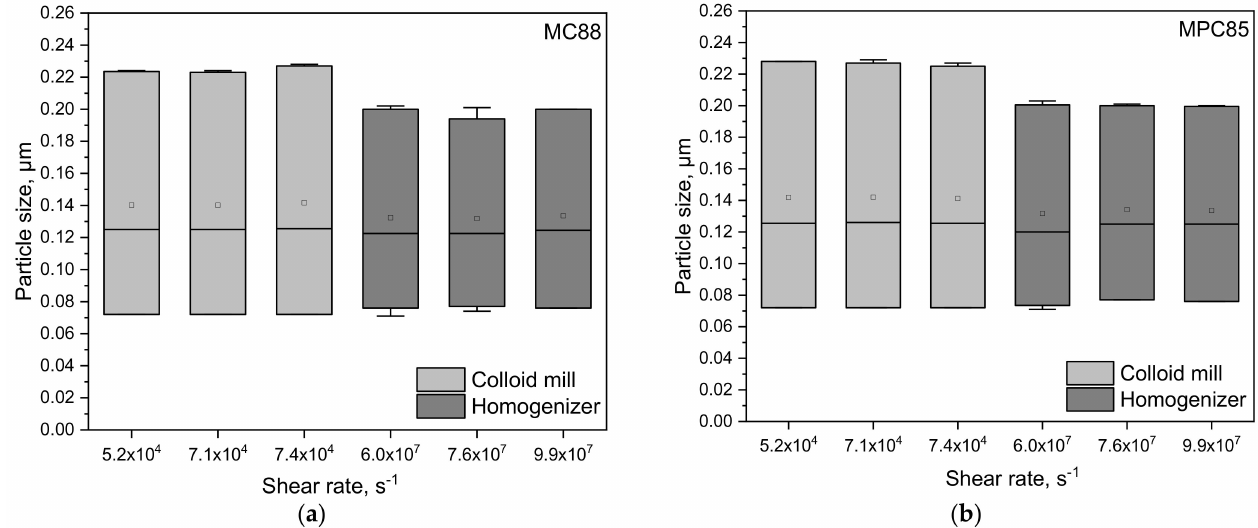
Figure 1. d 10 , d 50 , and d 90 represented as boxplots of skim milk enriched with MC88 ( a ) and MPC85 ( b ) after homogenization with colloid mill and high-pressure homogenizer at shear rates ≥ 5.2 × 10 4 and ≥ 6.0 × 10 7 s − 1 , respectively. The low and high quartiles, the median, and the mean ( (cid:3) ) are